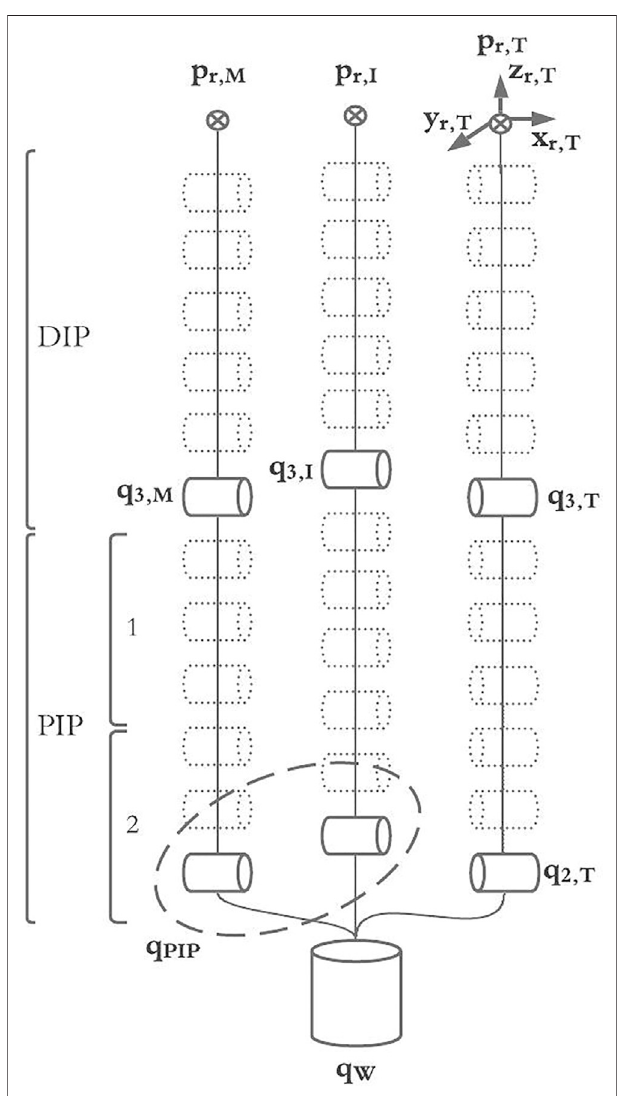
FIGURE 2 | The full kinematic model of the MUSHA hand and the reduced model into joint actuated space.